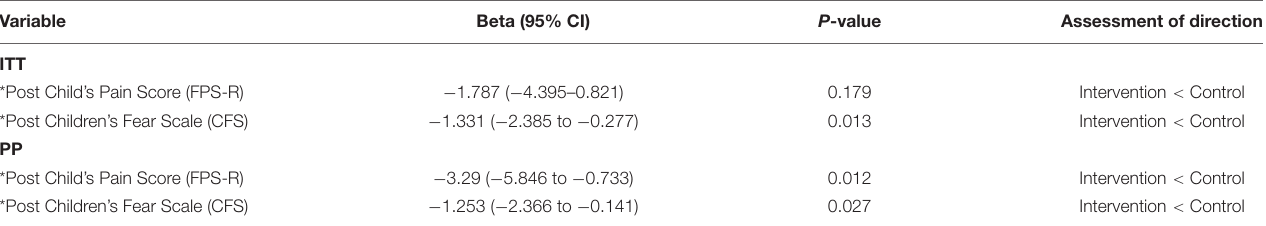
TABLE 6 | Association of post pain and fear score with intervention using linear regression.